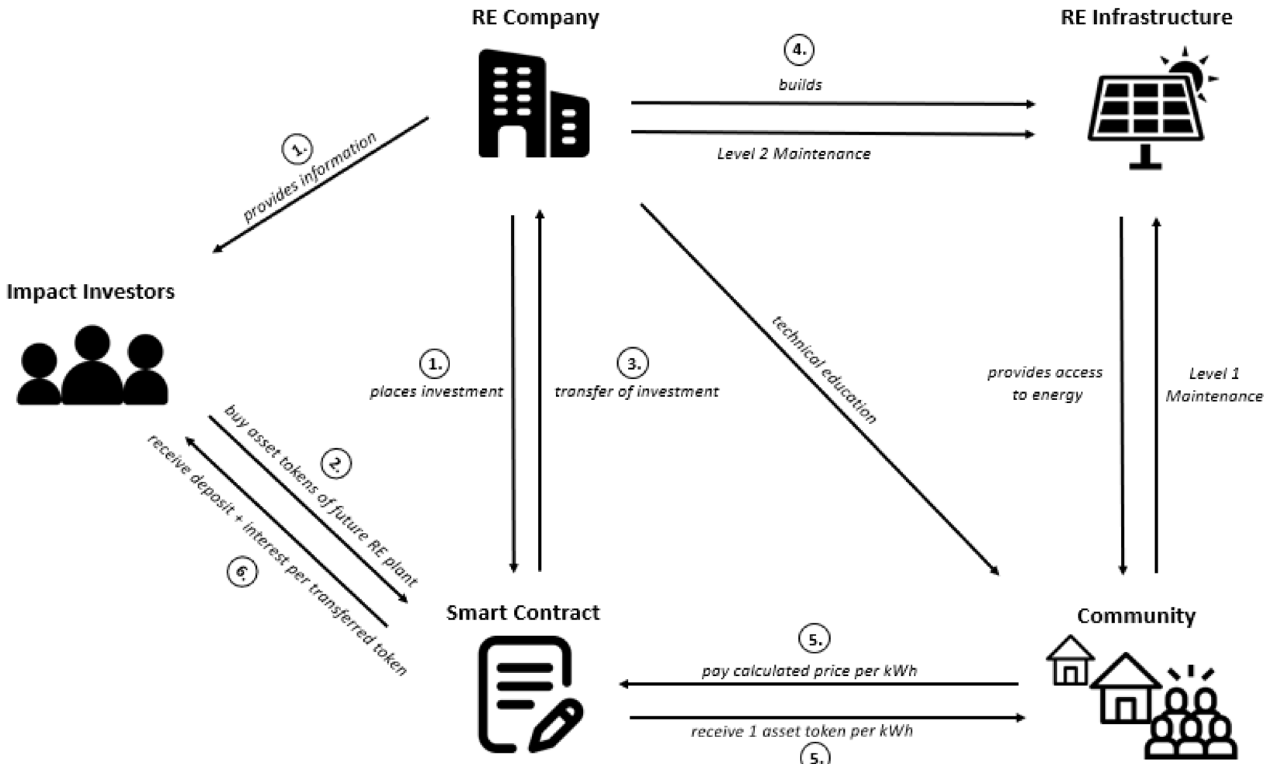
Fig. 4. Extension of CSOP model integrating blockchain